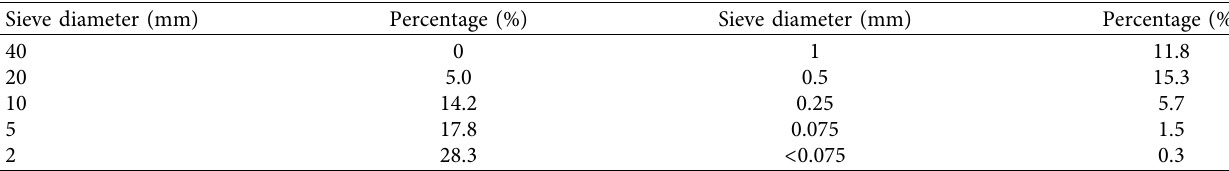
Figure 2: Landscape of the studied slope: (a) before slope protection; (b) after planting plants. Table 1: Results of the sieving analysis test [26].